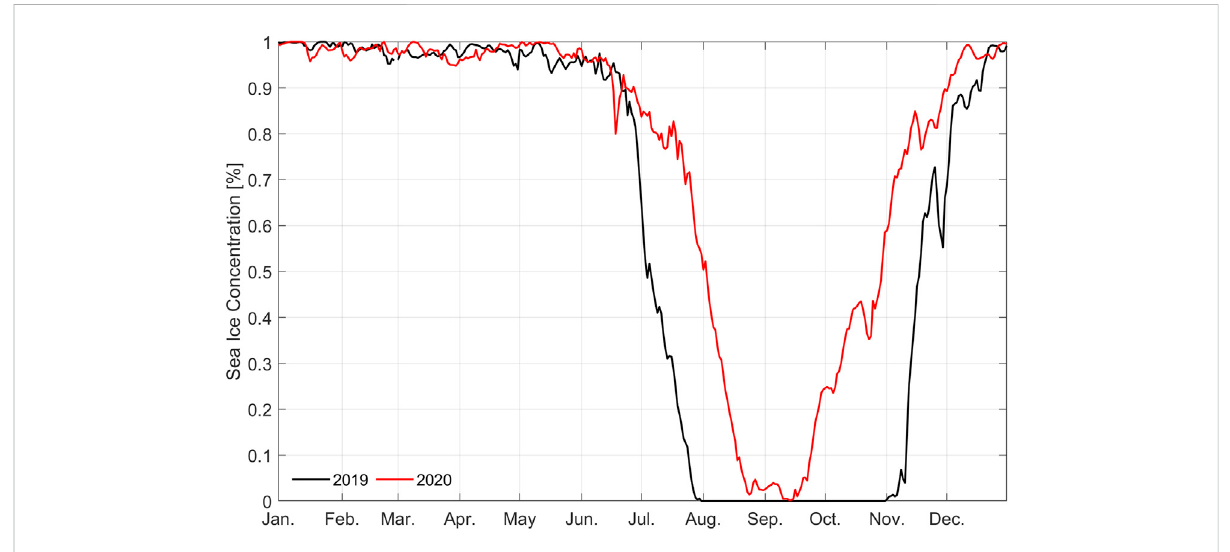
FIGURE 3 Regional average (73 – 75 ° N and 168 – 150 ° W) daily SIC for 2019 (black) and 2020 (red) based on satellite observation